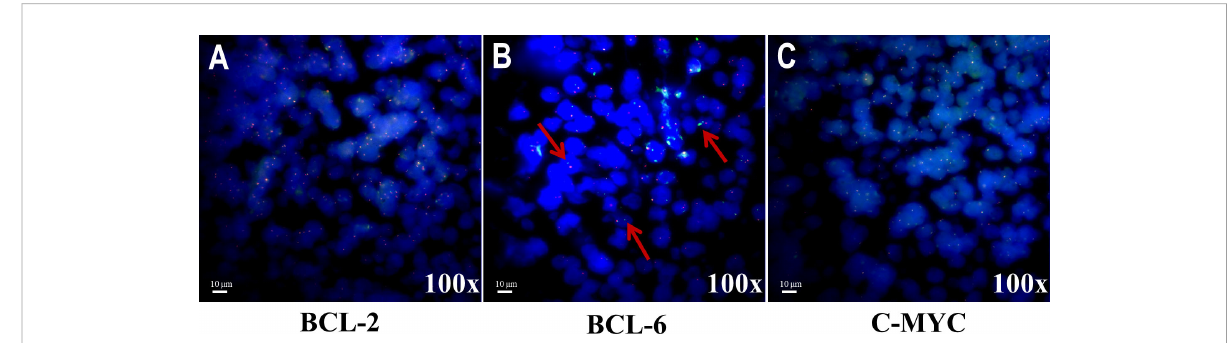
FIGURE 3 Representative images of translocation statuses by FISH analysis for three genes. (A) Tumor nuclei were negative for translocation of BCL-2. (B) Tumor nuclei were positive for translocation of BCL-6. Multiple tumor nuclei were seen with distinct red and green signals (highlighted by the red arrows). (C) Tumor nuclei were negative for translocation of C-MYC.